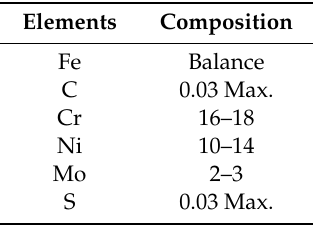
Table 1. Chemical Composition of 316L stainless steel